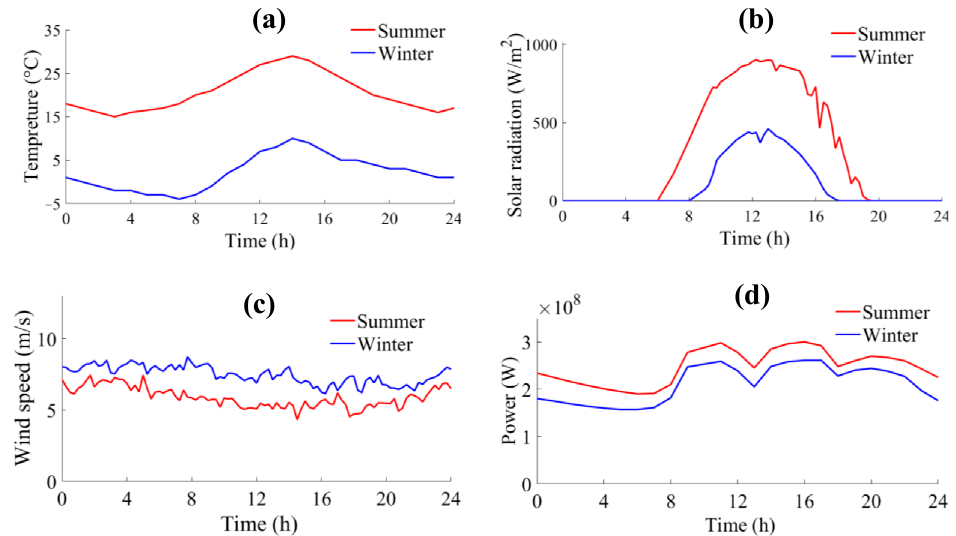
Figure 6. Ultra-short-term forecasting parameters: ( a ) Air temperature, ( b ) Solar radiation intensity, ( c ) Surface wind speed, ( d ) Load demand curve. ( c ) Surface wind speed, ( d ) Load demand